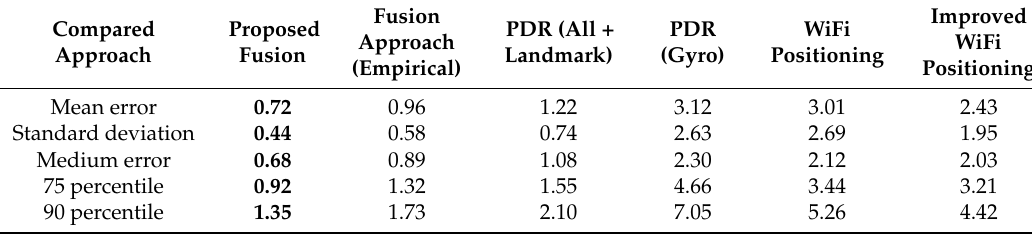
Table 3. Performance comparisons of various positioning error (m)